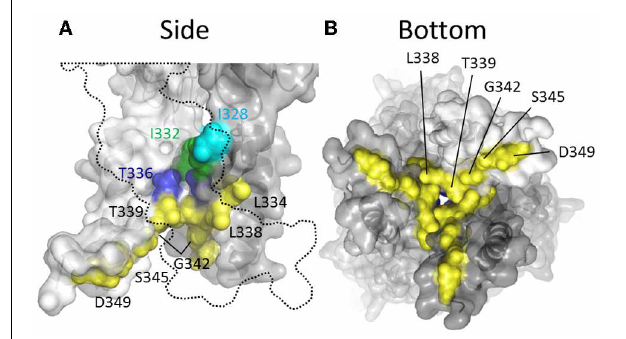
FIGURE 6 | Mapping P2X2R TM2 side-chains accessible to water-soluble thiol-reactive agents in the closed state using SCAM. (A) Side view of TM domains. Two subunits are shown with the third omitted for clarity (dotted outline). (B) TM domains viewed from the intracellular side of the membrane. The colored residues indicate positions at which substitution with cysteine produces a mutant that mediates currents sensitive to modification by thiol-reactive agents applied in the closed channel state. Color coordination is as follows: Cyan, mutant currents modified by external MTSEA + and MTSET + applied in the closed state; Green, mutant currents modified by external Ag + , Cd 2 + , and MTSET + applied in the closed state; Blue, mutant currents modified by external Cd 2 + applied in the closed state; Yellow, mutant currents modified by intracellular MTSEA + applied in the closed state.